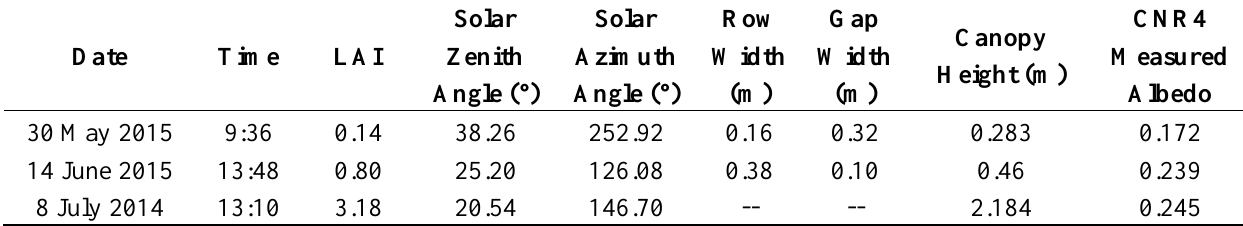
Table 2. The measured parameters on three individual